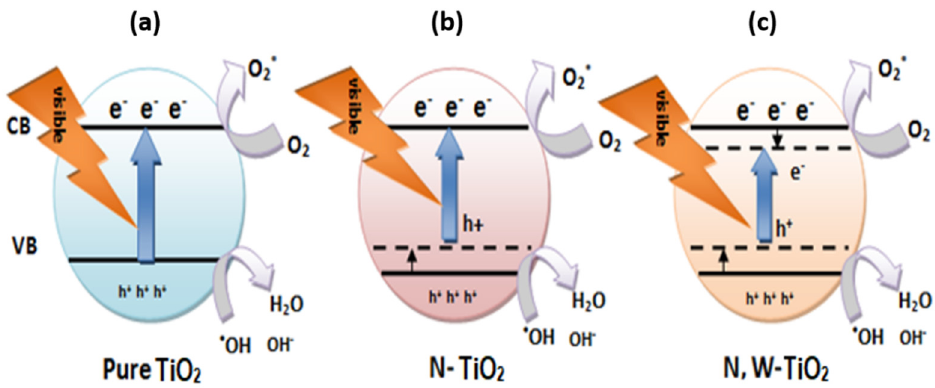
Figure 2. Plausible pathway for the photocatalytic degradation of dye by ( a ) undoped Titania; ( b ) TiO 2 doped solely with N; ( c ) N, W co-doped TiO 2 .